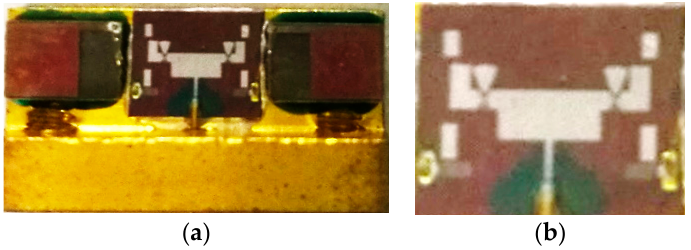
Figure 6. The photograph of the proposed pattern reconfigurable antenna taken by a microscope. ( a ) The antenna with testing holder. ( b ) Close-up of the antenna.